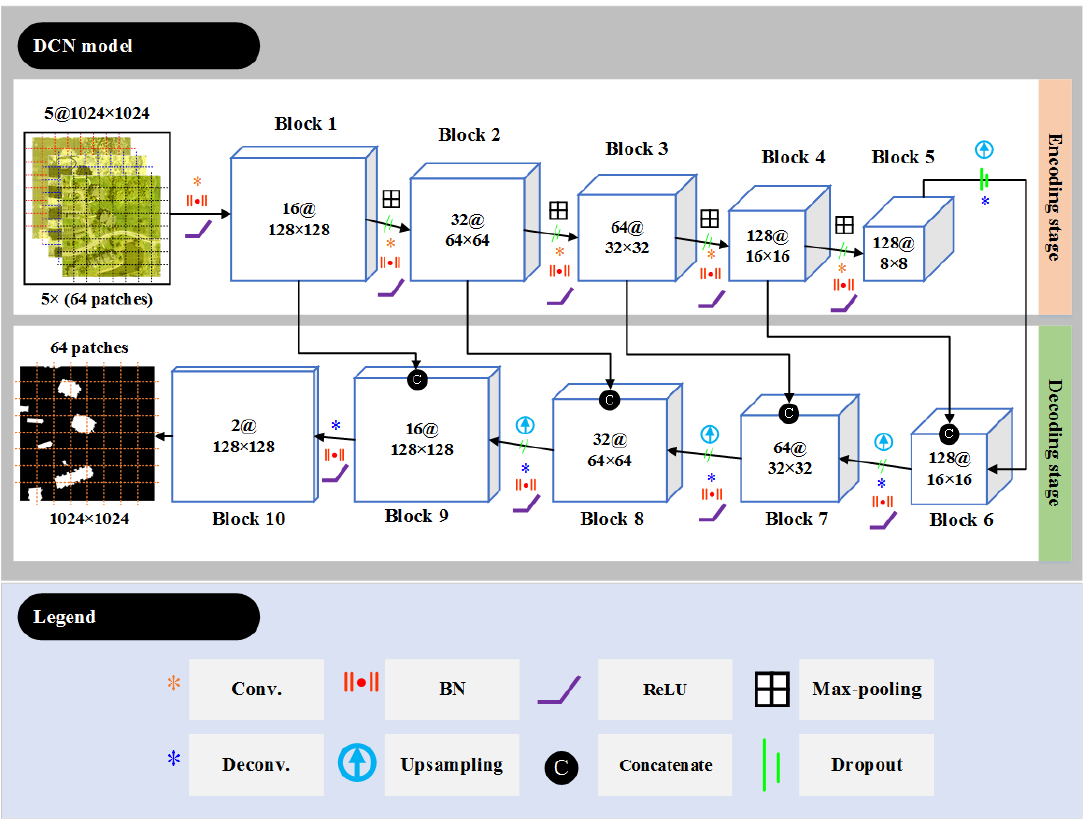
Figure 1. Architecture of the proposed DCN